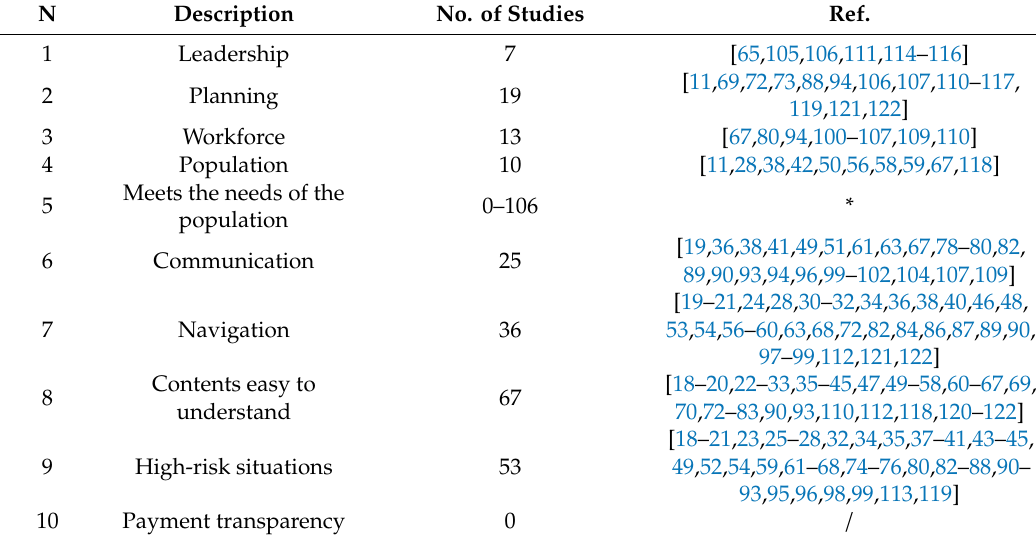
Table 5. Attributes (see Supplementary File for more